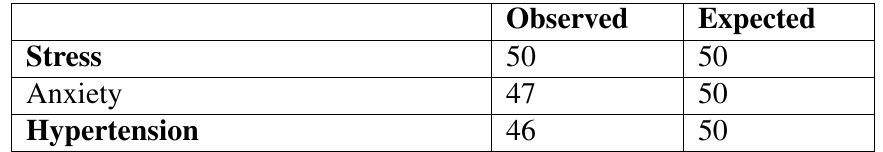
Table 5: Contingency Table for Chi- square